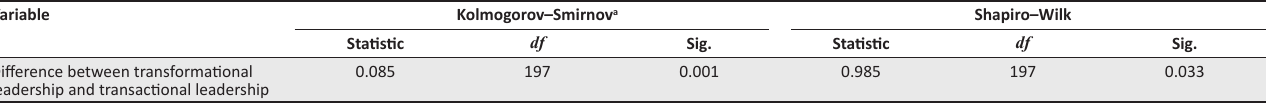
TABLE 3: Statistical analysis of the difference between transformational leadership and transactional leadership using Kolmogorov–Smirnov test for normality. Variable Kolmogorov–Smirnov a Shapiro–Wilk Statistic Sig. Sig. Difference between transformational leadership and transactional